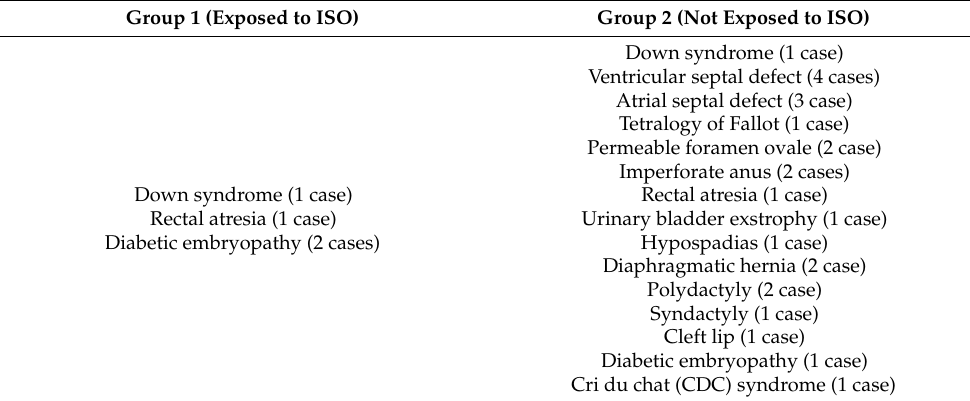
Table 3. Types of congenital malformations encountered in the two groups.